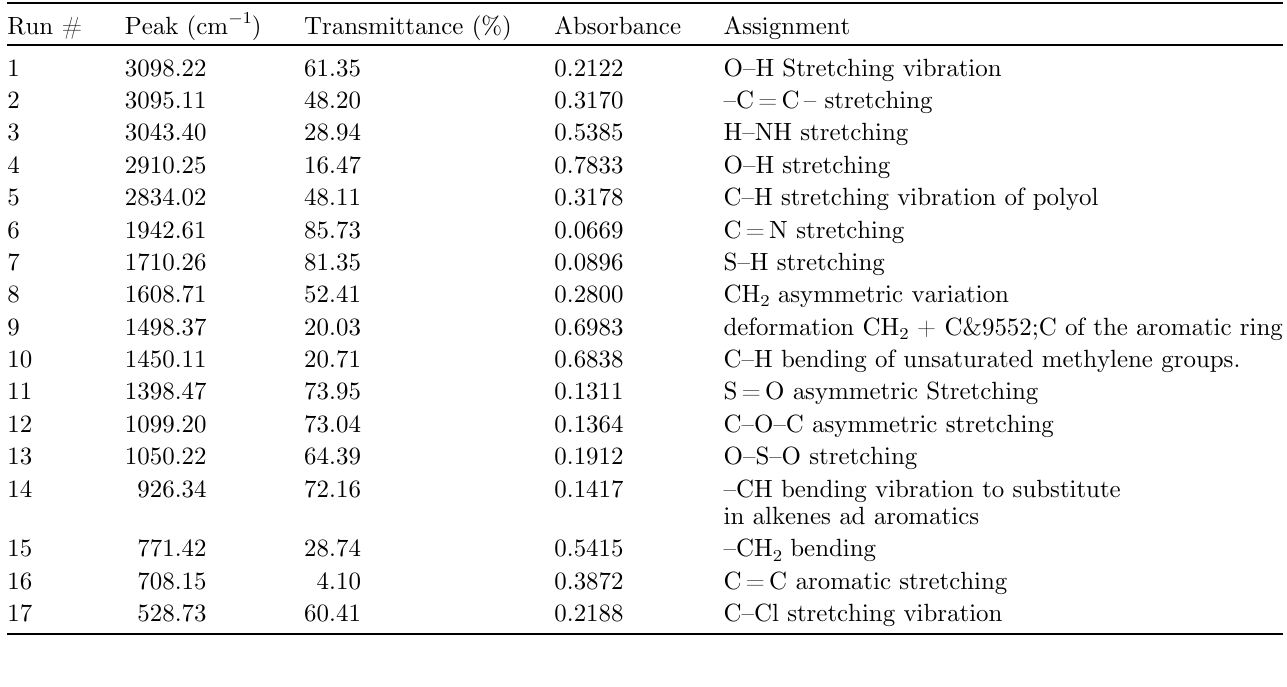
Table 3. FTIR spectrum values for un fi lled PU foam.